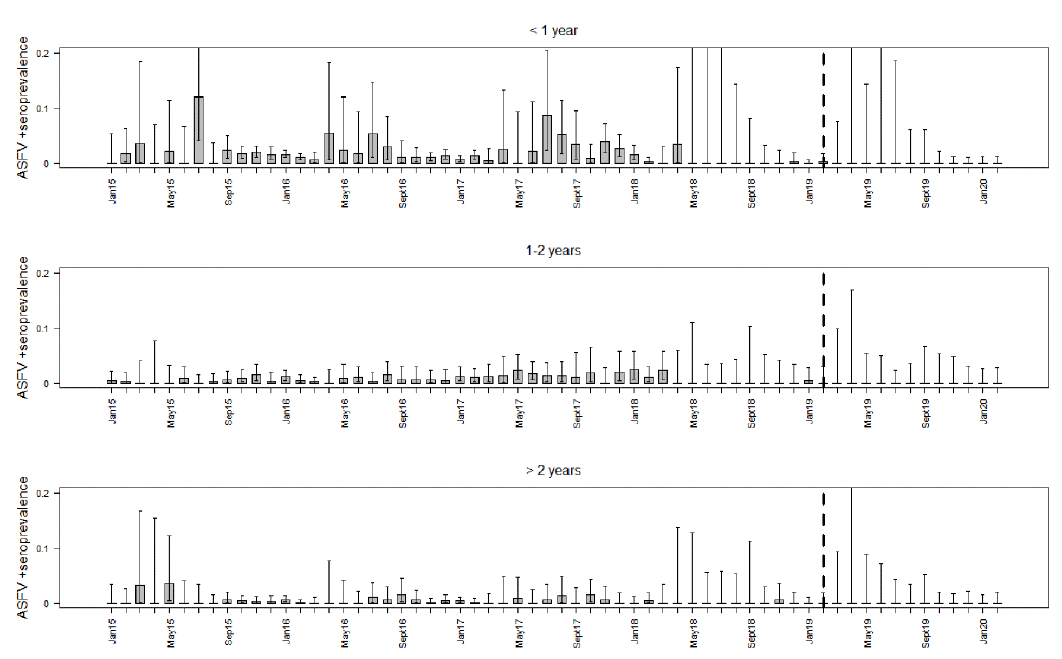
Figure 3. Prevalence estimates for ASFV PCR-positive and seropositive wild boar test results for each study month and three age classes. The whiskers indicate 95% confidence intervals. The broken vertical line highlights February 2019, the last month, in which ASFV-positive wild boar were detected.